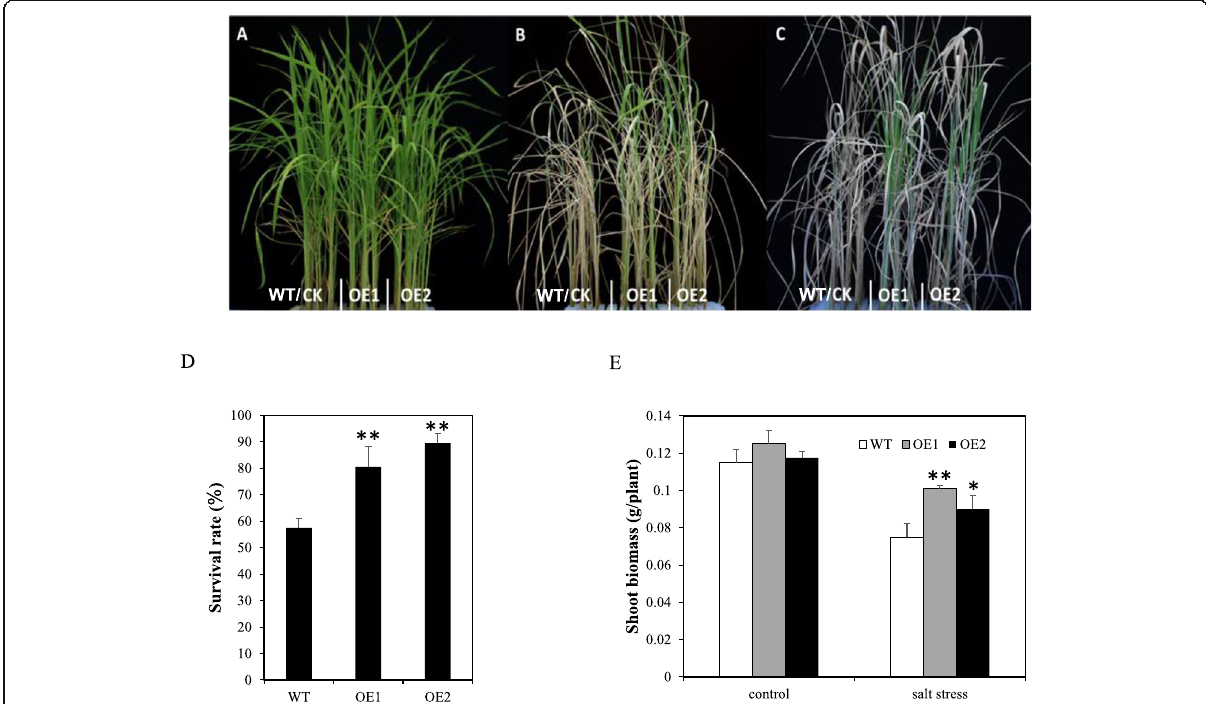
Fig. 5 Salt stress in the OsSTAP1 -overexpression lines. Phenotypes of WT and OsSTAP1 OE plants at the seedling stage in response to salt stress: before treatment ( a ), 150 mM NaCl for 5 days ( b ), and recovery for 7 days ( c ). Survival rates after recovery for 3 days ( d ), and shoot biomassof the OE and WT plants under the control and salt stress conditions ( e ). Each column are means ±SD ( n = 3. * and ** indicate significant difference at P <0.05 and P <0.01, respectively, based on Dunnett ’ s multiple comparison tests in